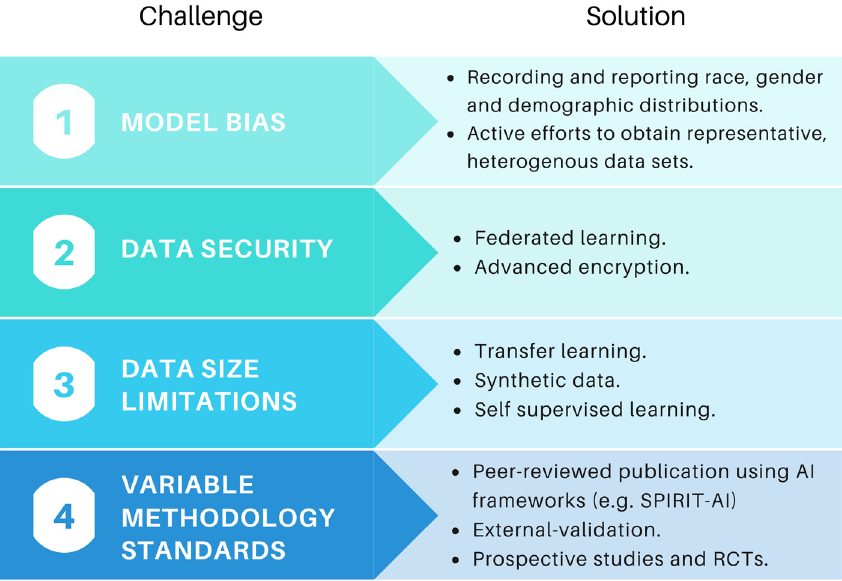
Figure 6. Challenges and possible solutions to improve the robustness of AI models in the future.